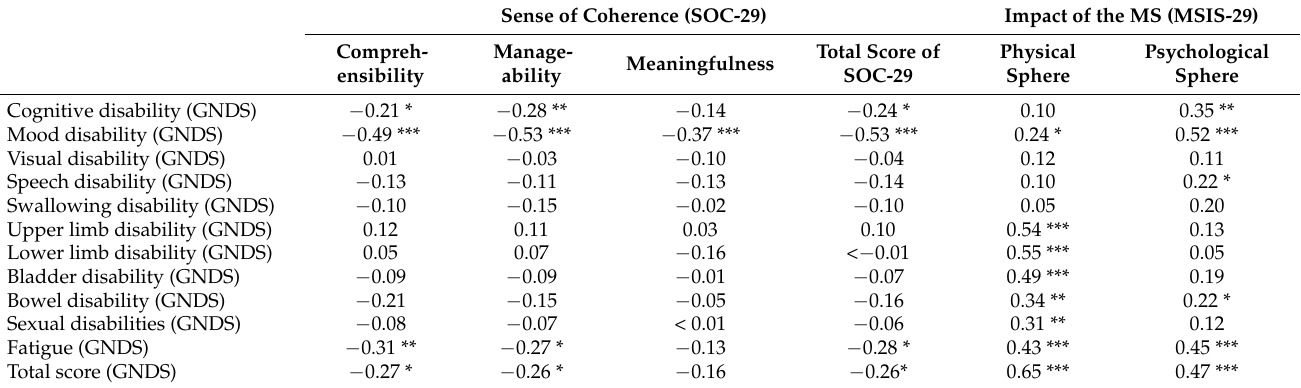
Table 5. Results of the Pearson’s r